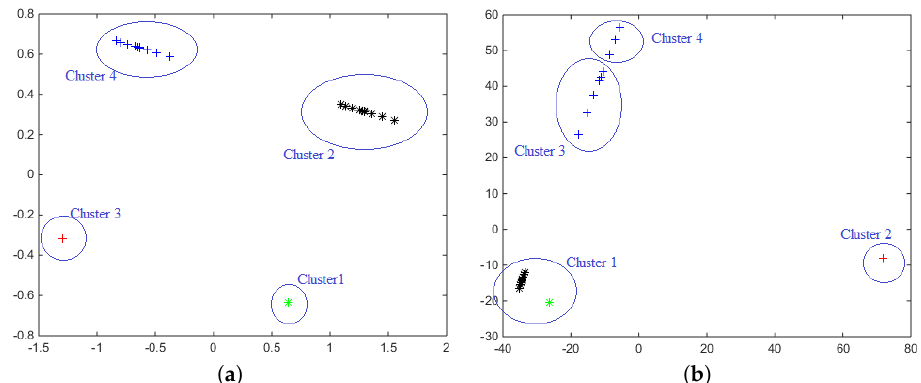
Figure 6. MDS applied to the distance matrices: ( a ) using d new , ( b ) using d 2 . The ten initial spirals are marked with green asterisks and the ten initial circumferences are represented with black asterisks, the enlarged spirals are plotted in red and the enlarged circumferences are plotted in